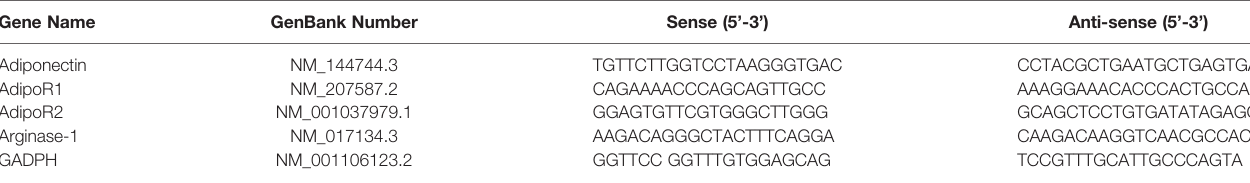
TABLE 1 | Primers used in real-time PCR for the target